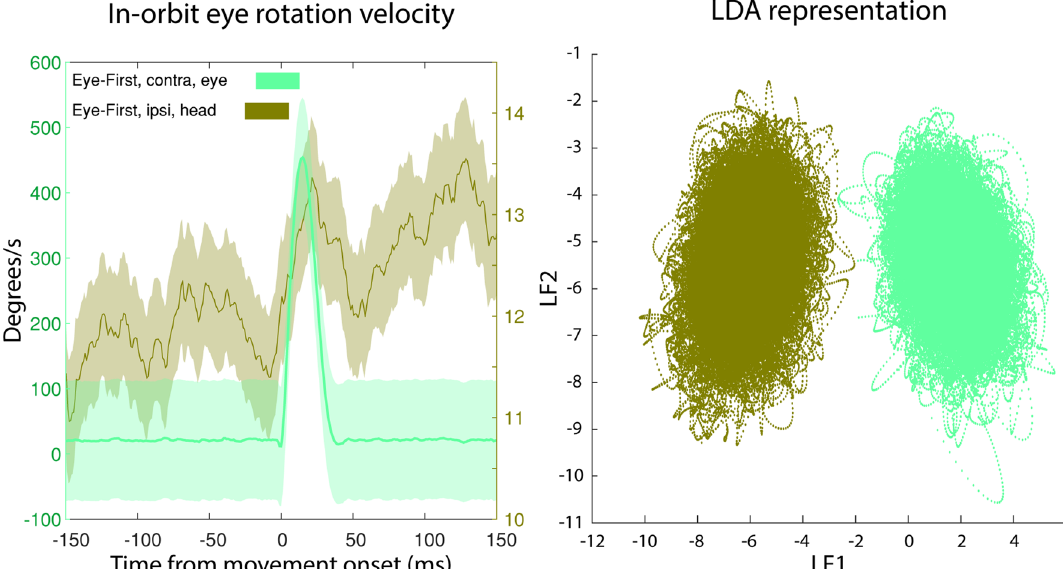
Figure 9. Comparison of the contraversive rotations of the eye in the orbits during separate conditions. Left: Eye-in-orbit velocity. Green line shows the eye velocity centered on eye movement onset for a contraversive movement on an eye-first condition. In this case the eye rotates in the head as a saccade in a contraversive fashion. Brown color represents the eye velocity as the head is making an ipsiversive movement. Thus, the eye is counter-rotating in the head in the contraversive direction, albite more slowly than in green condition. Shaded regions are 2 standard deviations around the mean. Note that different y-axis scales are used for the two traces. Right: LDA representations of PMv activity associated with the two conditions shown in panel A. The LDA results show clear separability in the population although the eye rotation in the head was in the same direction in both cases.